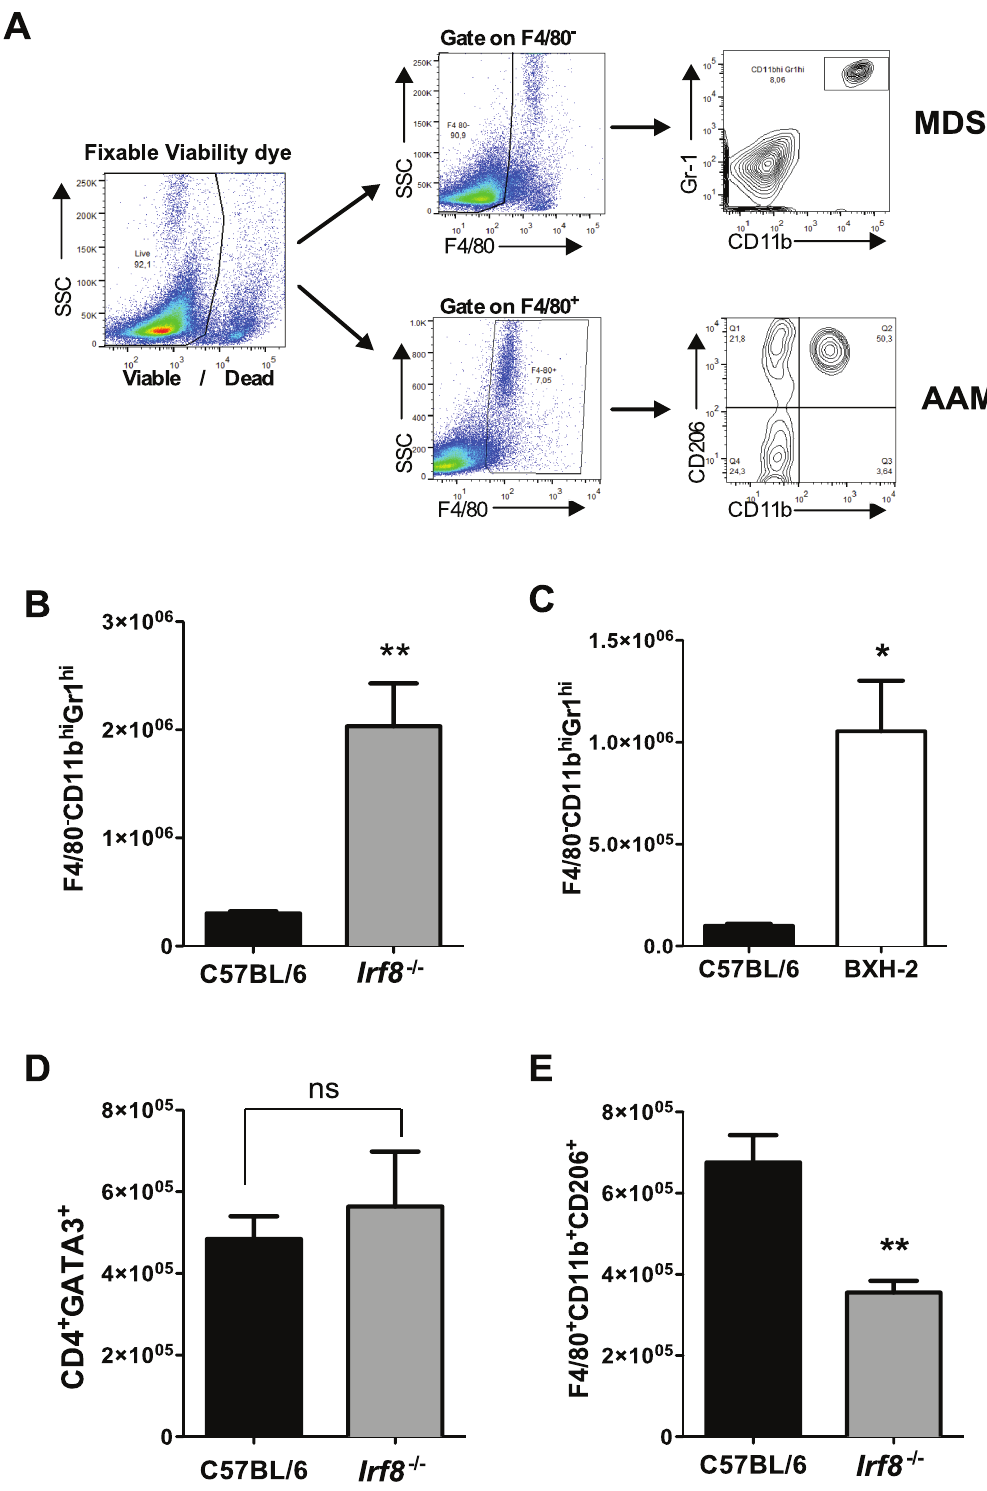
Fig 2. Immunophenotype of cells in MLN of C57BL/6 and IRF-8 deficient mice after primary Hpb infection. (A) Gating strategy used to analyzeF4/80 - CD11b hi Gr1 hi (MDSC) and F4/80 + CD11b + CD206 + (AAM Ø ) cells by flow cytometry. Total numbers of F4/80 - CD11b hi Gr1 hi cells in MLN of (B) C57BL/6(B6) and Irf8 -/- mice and (C) B6 and BXH-2 mice on day 14 p.i. Total numbers of (D) CD4 + GATA3 + T cells and (E) F4/80 + CD11b + CD206 + cells in MLN